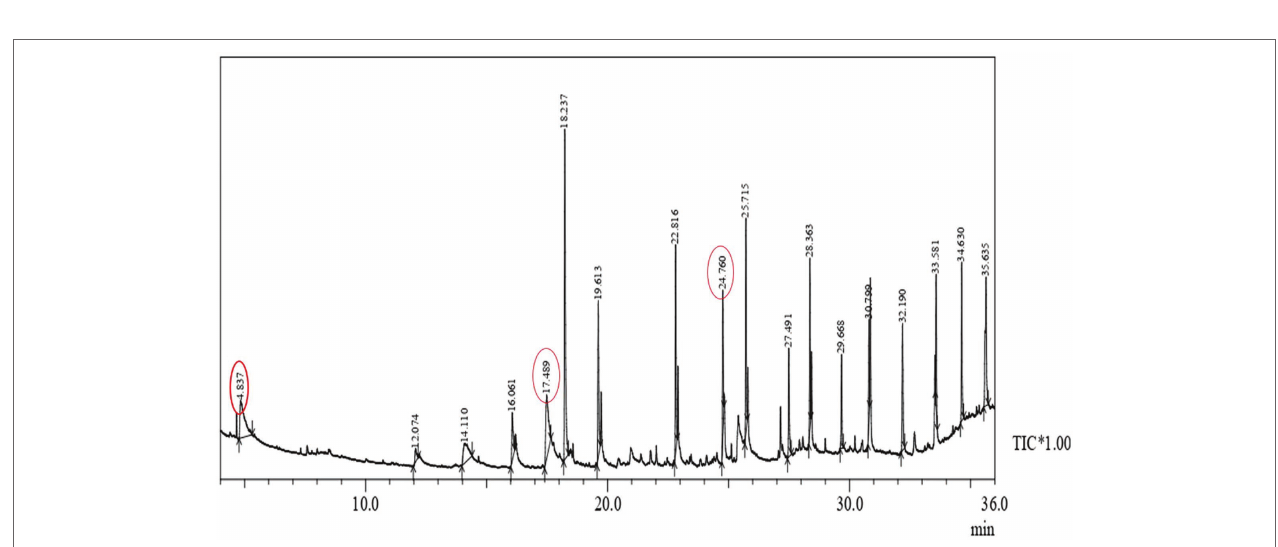
FIGURE 8 | Fourier transform infrared spectroscopy (FTIR) spectra of extracted polymer from P. aeruginosa EO1.